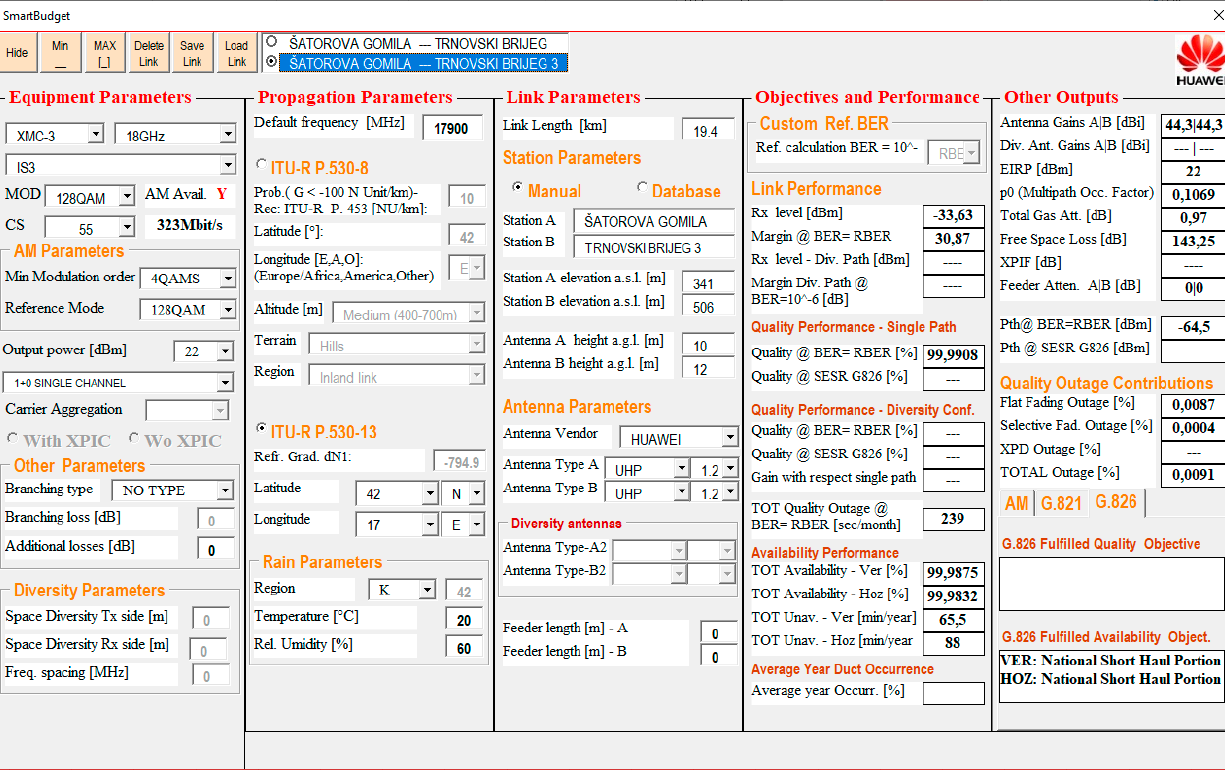
Figure 11. Prediction for the first RR section; 128 QAM, 323 Mb/s.